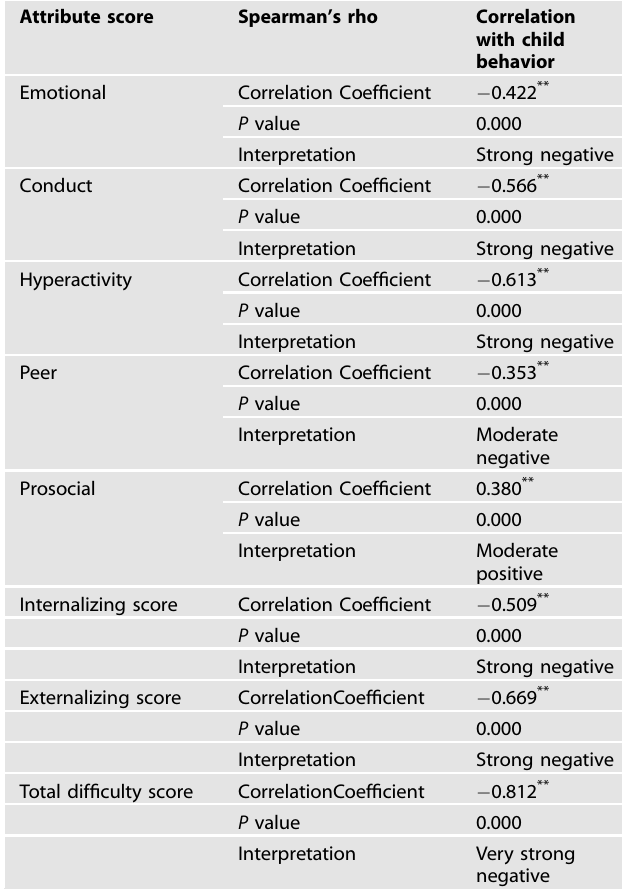
Table 2. Distribution of different psychological attributes, internalizing, and externalizing problems among study